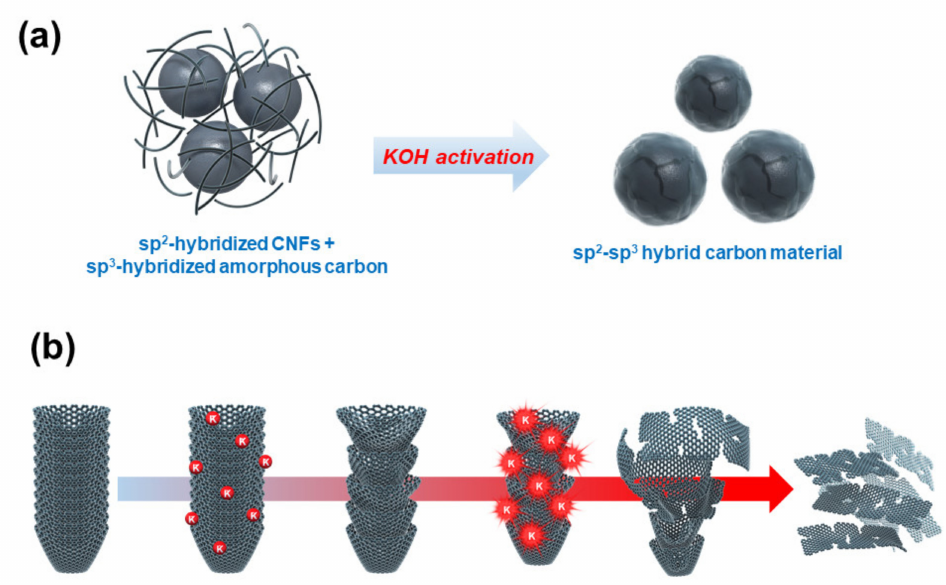
Figure 1. Schematic diagram of the hybrid porous carbons (HPCs) induced by KOH activa- tion. ( a ) sp 2 –sp 3 HPCs exhibit 3D spherical morphology covered with a thin carbon nanosheet. ( b ) Structural change of herringbone-CNFs by KOH activation process. The resultant CNFs form ribbon-like